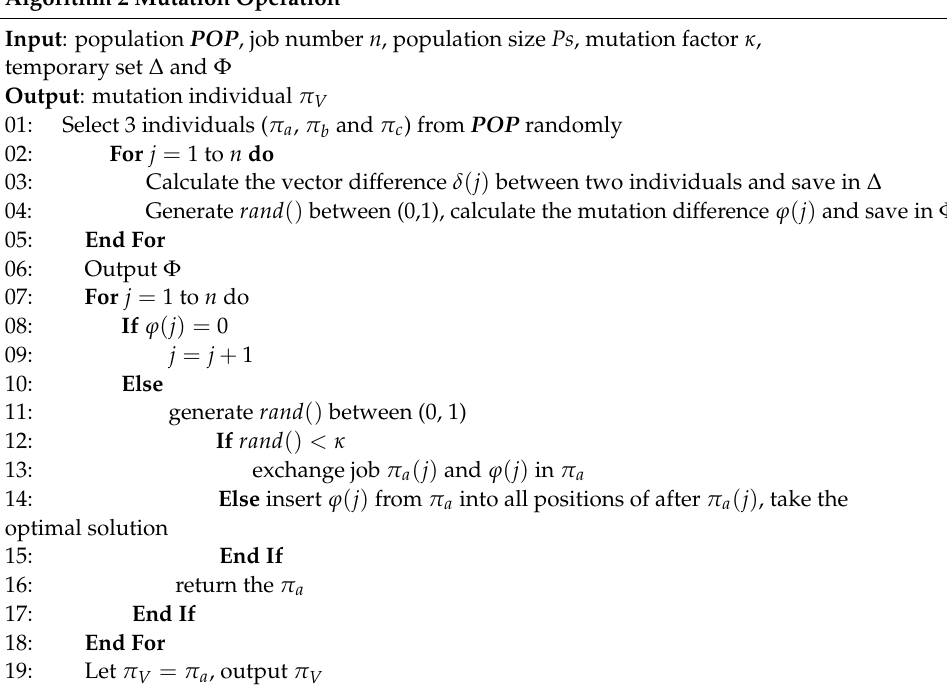
Algorithm 2 Mutation Operation